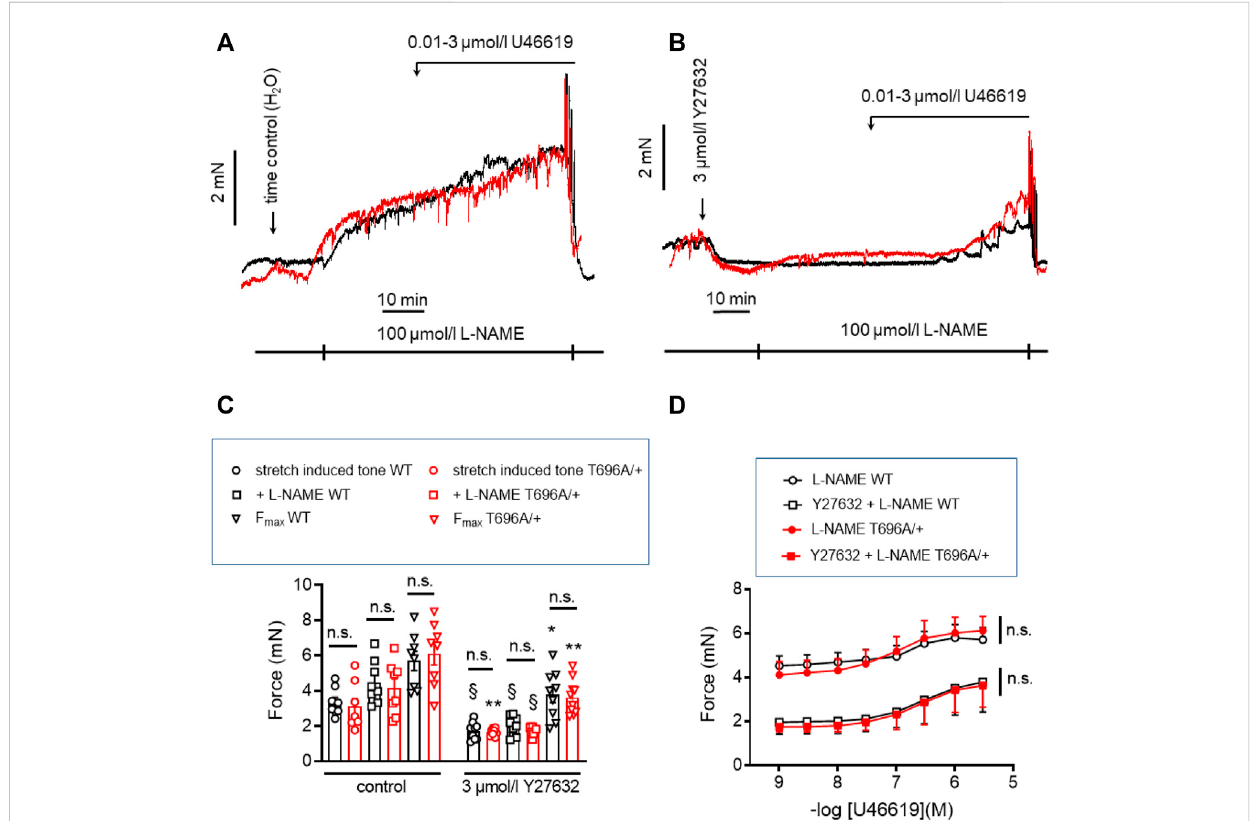
FIGURE 4 Stretch-, L-NAME-, and U46619-induced tone in arterial rings from senescent basilar arteries from WT and MYPT1-T696A/+ -mice under control conditions and under inhibition of ROK. (A,B) Original force tracings of the experiments performed with s-BAs from WT and MYPT1-T696A/+ -mice pretreated with vehicle [1% H 2 O; (A) ] or 3 μ mol/L Y27632 (B) and followed by inhibition of endogenous NO by treatment with 100 μ mol/l L-NAME and cumulativeapplication ofU46619(conc.0.001 – 3 μ mol/L). (C) Statisticalevaluationofstretch-induced,L-NAME-inducedandmaximaltone( n =8). (D) Statistical evaluation of tone induced by cumulative application of U46619 ( n = 8). Data are represented as absolute force ±SEM; n.s. p > 0.05; two- wayANOVA.§ p < 0.0001,stretch-inducedtoneWTcontrols(notreatment)vs.stretch-inducedtoneWTafter10 mintreatmentwith3 μ mol/LY27632,or stretch-induced tone L-NAME WT no treatment vs. stretch-induced tone L-NAME WT after 10 min treatment with 3 μ mol/L Y27632, or stretch-induced tone L-NAME MYPT1-T696A/+ no treatment vs. stretch-induced tone L-NAME L-NAME MYPT1-T696A/+ after 10 min treatment with 3 μ mol/L